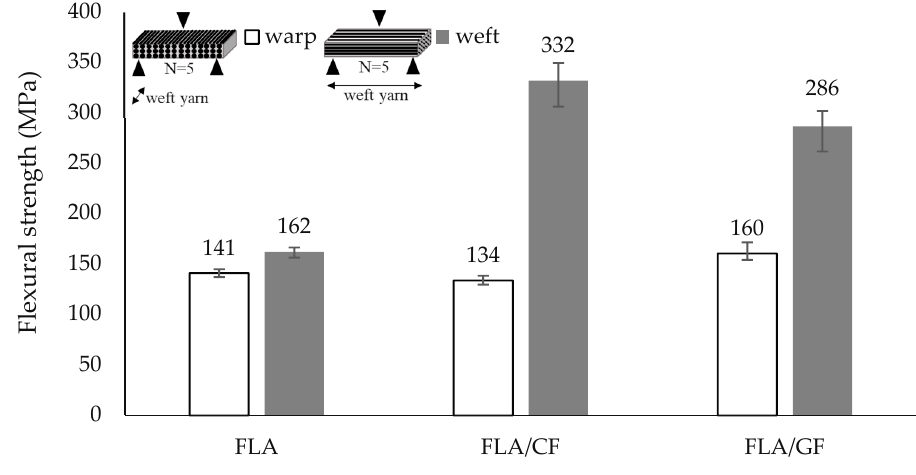
Figure 10. Flexural strength of hybrid composites.